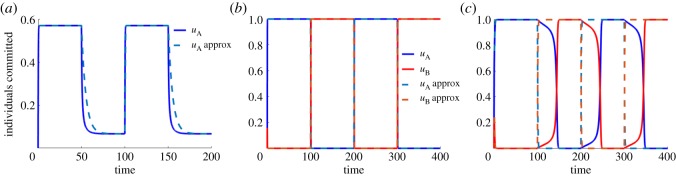
Linear approximation of the switch induced periodic solutions is generally accurate in (a) the single-feeder choice model (α¯=2, T = 50 min, γ = 2.8 and β = 3) and (b) two-feeder choice model (direct switching here with model parameters α¯=2, T = 100 min, γ = 0.01, β = 0.1 and ρ = 10). (c) However, when studying the discriminate stop-signalling model close to the saddle-node bifurcation, nonlinear effects shape the periodic solution of the full model equation (2.1) in ways that are not well approximated by the linearizations. Model parameters are α¯=2, T = 100 min, γ = 0.01, β = 3.6 and ρ = 1.